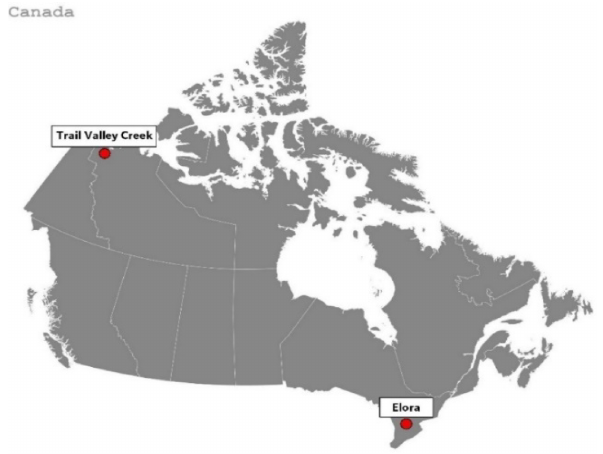
Figure 1. Locations of the southern Canada (Elora) and western Canadian Arctic (Trail Valley Creek) sites used in this study. The Elora site is located on an agricultural field and has a shallow, tem- perate snow cover. The Trail Valley Creek site is typical of the tundra–taiga ecotone with snow that is highly variable in depth, den- sity, and